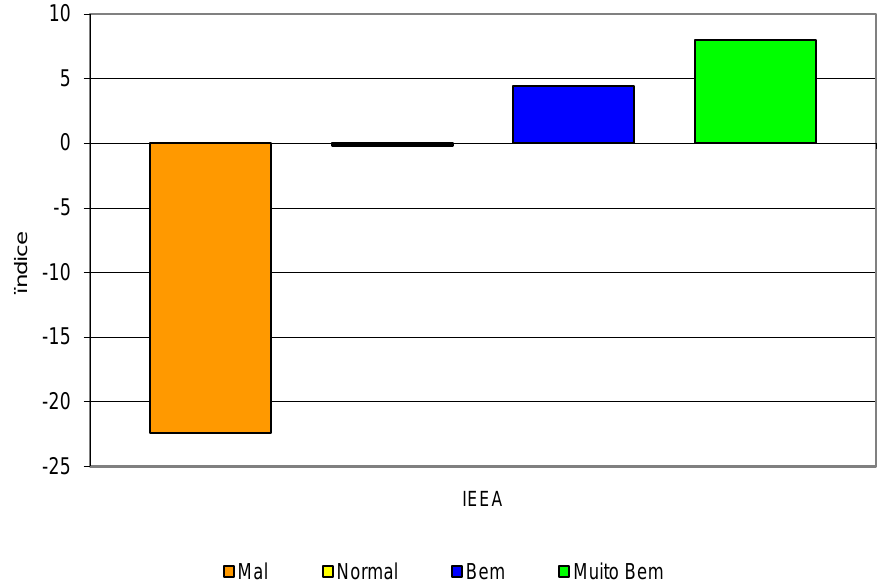
Figura 4. IEEA para o fa tor "Como você está na escola com relação a suas notas, tarefa e